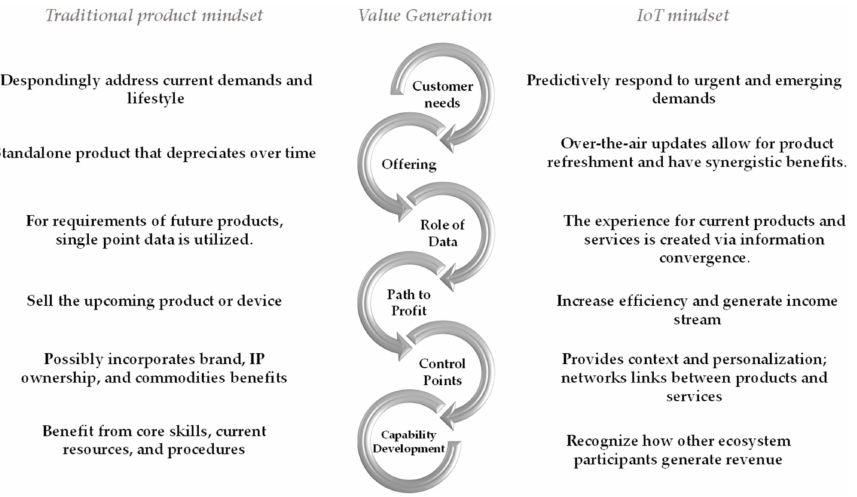
Figure 3. Comparison between traditional product and IoT mindset considering value